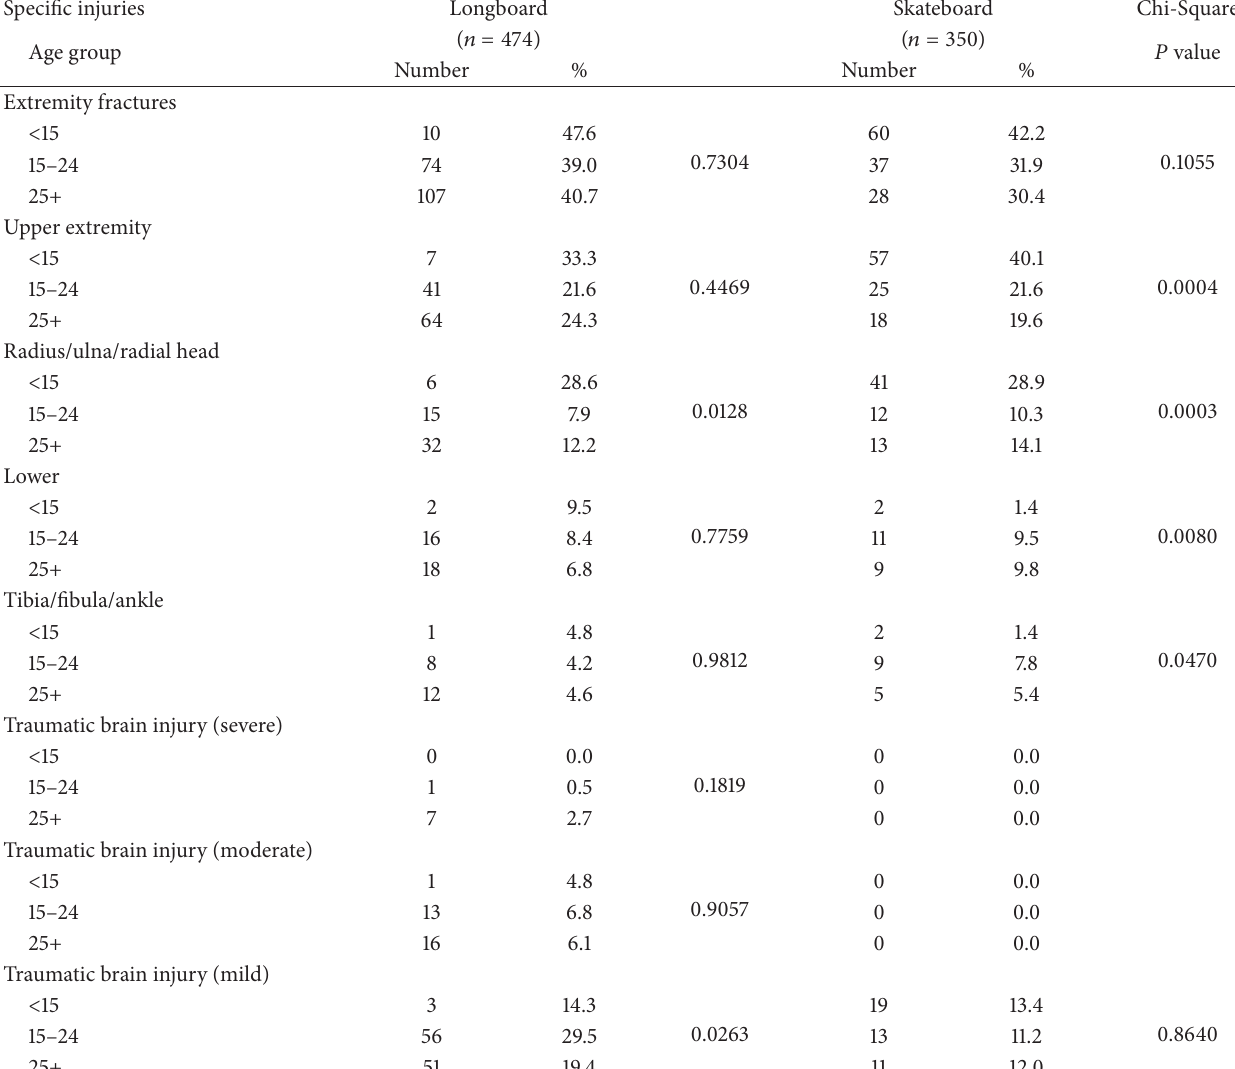
Table 5: Frequency of fractures and traumatic brain injury according to age for longboarders and also